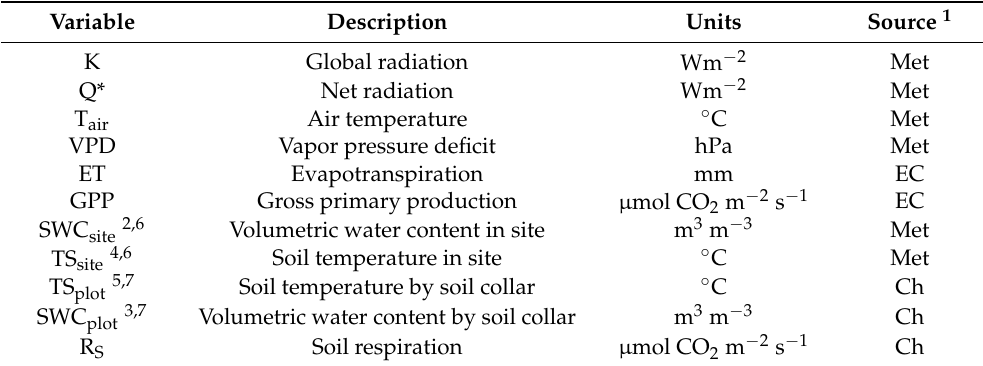
Table 2. Input of soil respiration, ecosystem flux and meteorological variables for structural equation models along a forest succession from tropical dry forest in northwestern